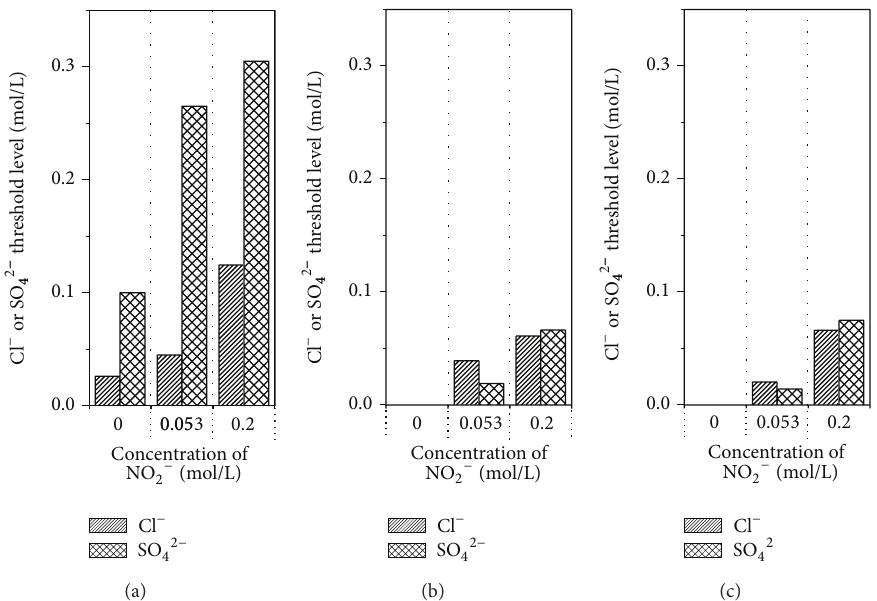
Figure 13: Comparing the threshold level of Cl − and SO 42− . (a) pH = 12.6, (b) pH = 10.3, and (c) pH = 8.1.